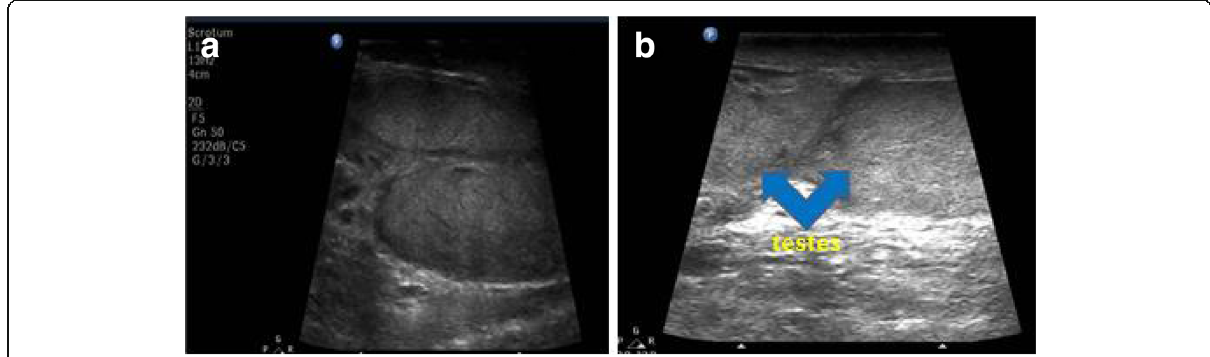
non-strangulated inguinal hernia with bowel loop and omentum as its content. MRI pelvis (Fig. 2) revealed TTE with both testes in